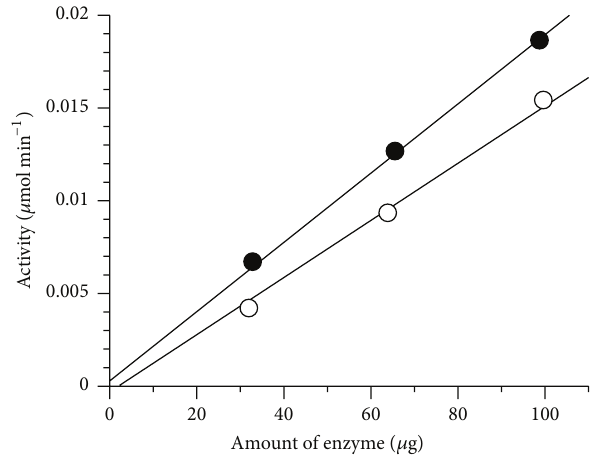
Figure 2: Linearity of synthetic peptide assay with amount of PeiW ( e ) or PeiP ( I ) using E 𝛾 ApNA as